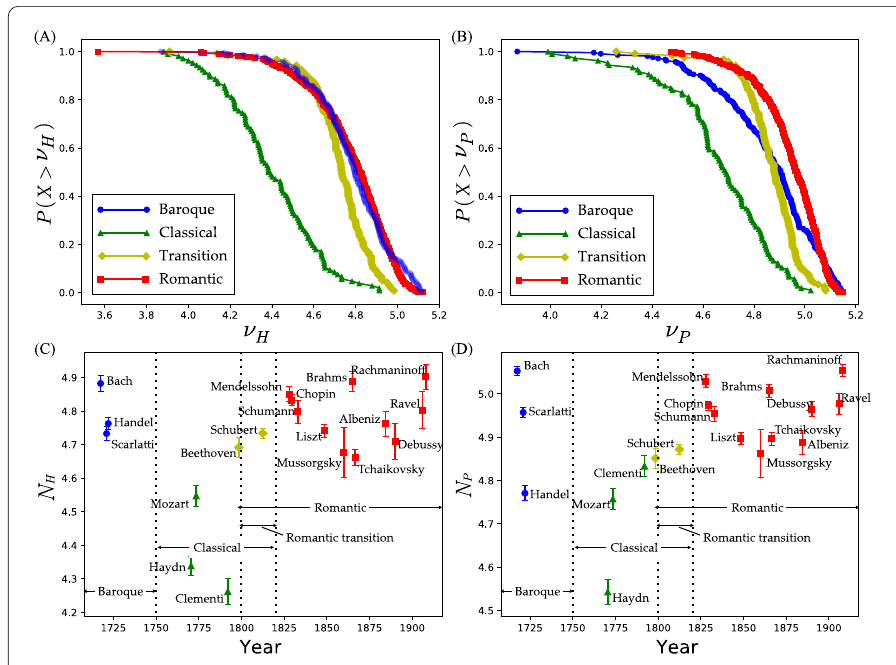
Figure 3 The H-novelty (left) and P-novelty (right) of the piano compositions (top) and the composers (bottom). ( A ) The cumulative distribution of the H-novelty scores ν H of the works. The median and mean values are (4.80,4.78) for the Baroque, (4.38,4.40) for the Classical, (4.73,4.729) for the Transition, and (4.82,4.78) for the Romantic periods. ( B ) The cumulative distribution of the P-novelty scores ν P of the works. The median and the means are (4.90,4.86) for the Baroque, (4.69,4.66) for the Classical, (4.88,4.87) for the Transition, and (4.97,4.94) for the Romantic periods. ( C ) & ( D ) The novelty N H and N P of the